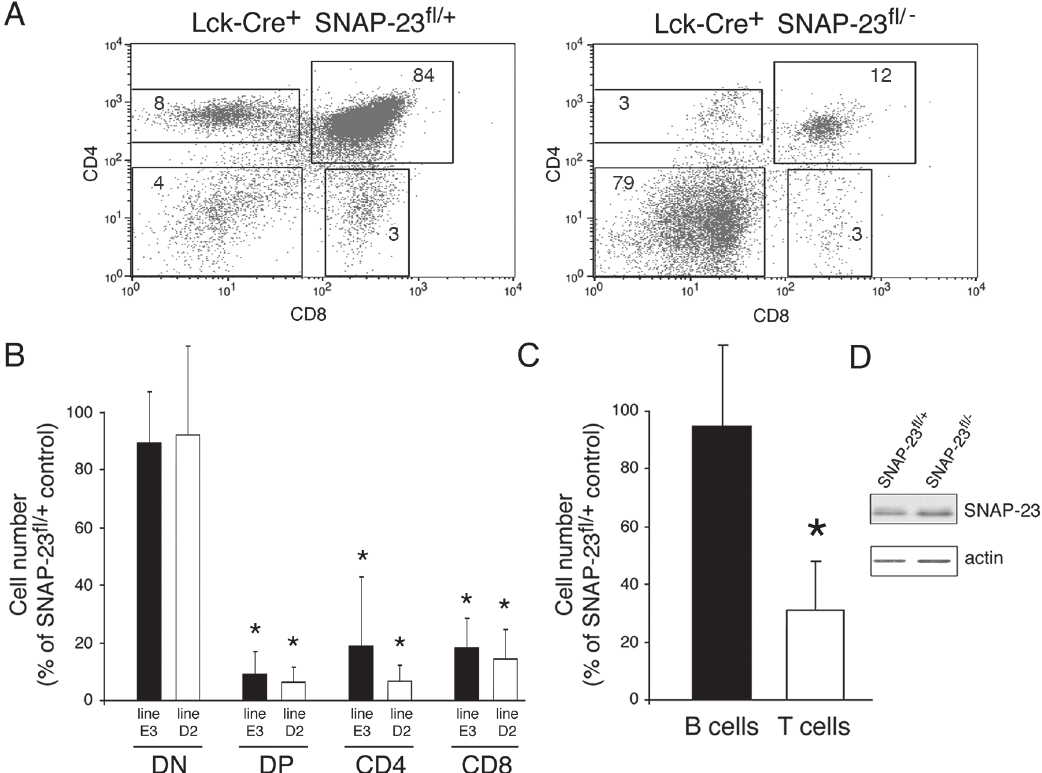
Fig 3. Deletion of SNAP-23 in Lck-expressing T cells prevents T cell development. Thymi were harvested from Lck-Cre + SNAP-23 fl/+ control mice or Lck-Cre + SNAP-23 fl/- mice and single cell suspensions were stained with fluorochrome-conjugated CD4- and CD8-mAb and analyzed by flow cytometry. (A) A representative flow cytometry profile reveals a dramatic reduction in the percentage of CD4 + , CD4 + 8 + , and CD8 + T cells in the thymus of an Lck-Cre + - expressing SNAP-23 fl/- mouse (line D2). (B) Quantitative analysis of matched pairs of littermate mice from SNAP-23 fl founder lines E3 or D2 indicate recovery of CD4 - CD8 - (DN), CD4 + CD8 + (DP), CD4 + , and CD8 + T cells present in thymi of Lck-Cre + SNAP-23 fl/- mice expressed as a percentage of those found in thymi of Lck-Cre + SNAP-23 fl/+ control mice (calculated based on the percentage of each cell type present as determined by flow cytometry). The data shown are mean +/- SD of three independent experiments ( * p < 0.05). (C) The recovery of the indicated cell types from the spleens of Lck-Cre + SNAP- 23 fl/- mice was expressed as a percentage of those found in Lck-Cre + SNAP-23 fl/+ control mouse spleens (line D5). The data shown are mean +/- SD of eight independent experiments ( * p < 0.05). (D) T cells were purified from the spleens from the indicated mice and equal numbers of cell equivalents were analyzed by SDS-PAGE and immunoblotting using a SNAP-23 antibody. The blot was re-probed for anti- β actin mAb as a loading control.